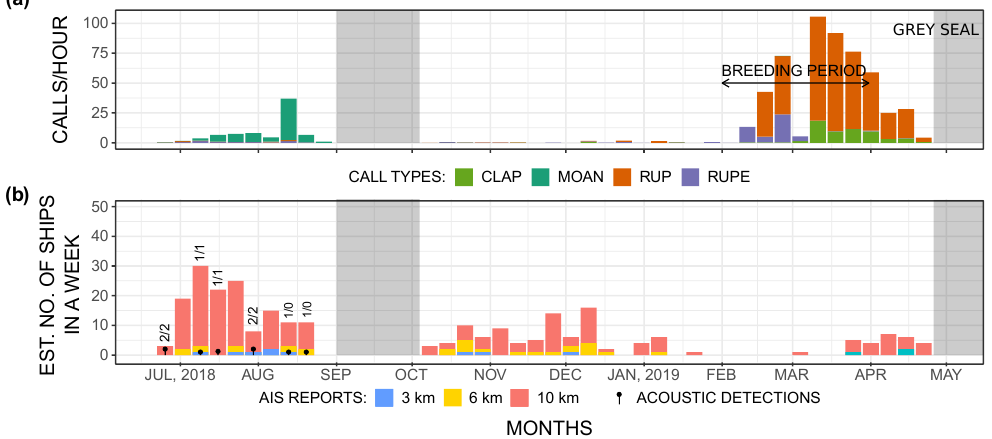
Figure 10. Biophony of ( a ) detected grey seal calls throughout the year. The number of detections increases significantly during the breeding period. The coloured bar charts in ( b ) show the number of ships and their respective ranges based on AIS position reports. The total numbers of the acoustically detected ships are shown by the lollipop chart. Numerical values of the detections written over the number of detected ships without AIS can be seen above the bars. All data are presented on a weekly